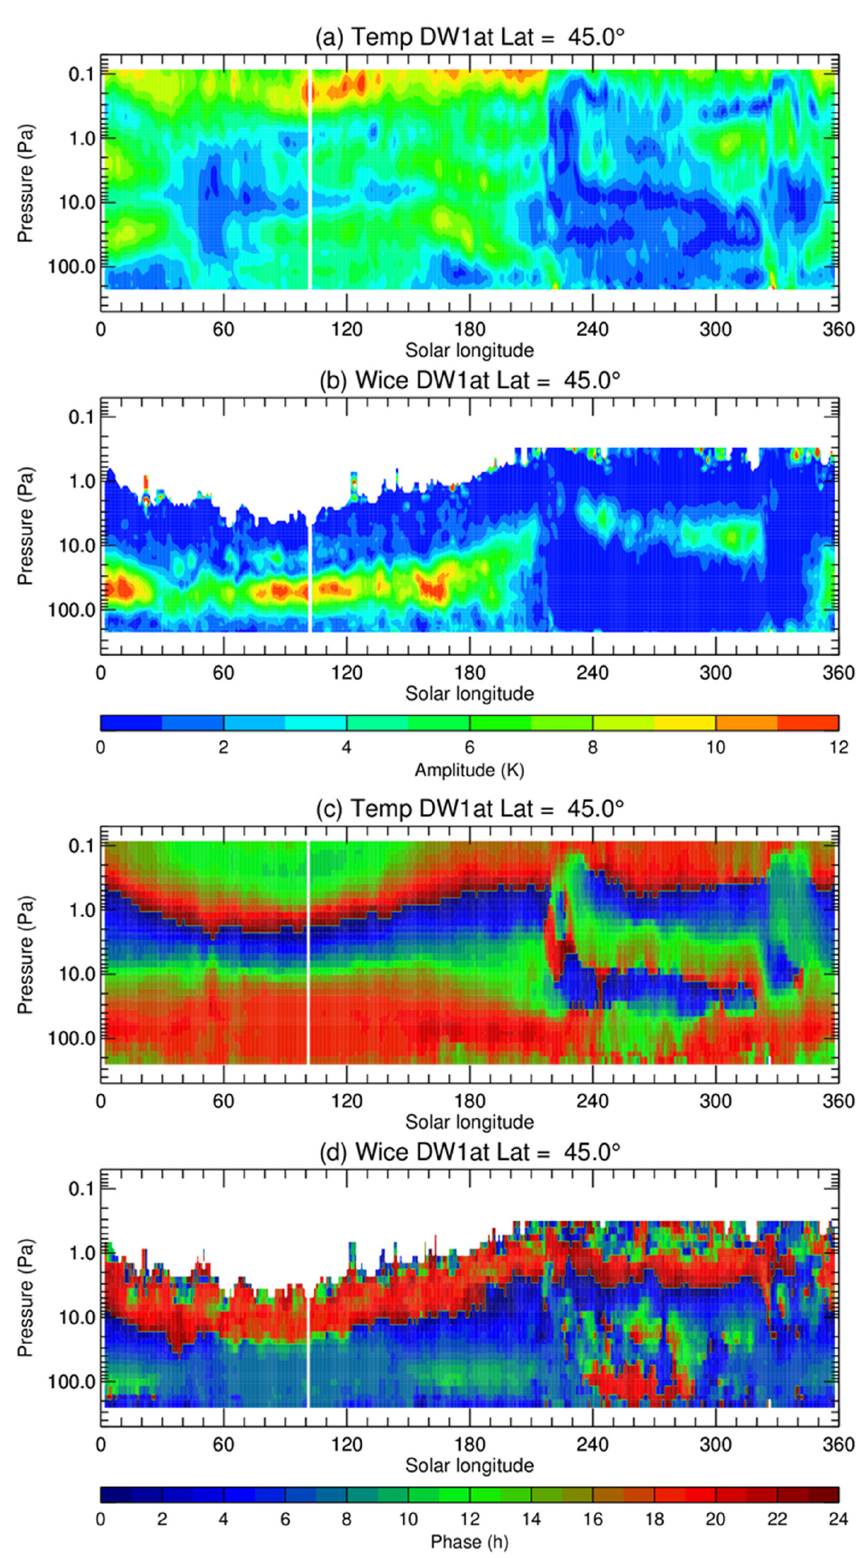
Figure 9. Seasonal variations of the temperature ( a , c ) and water ice ( b , d ) DW1 amplitude ( a , b ) and phase ( c , d ) at 45°N. Note that the water opacity value has been multiplied by 10 4 .